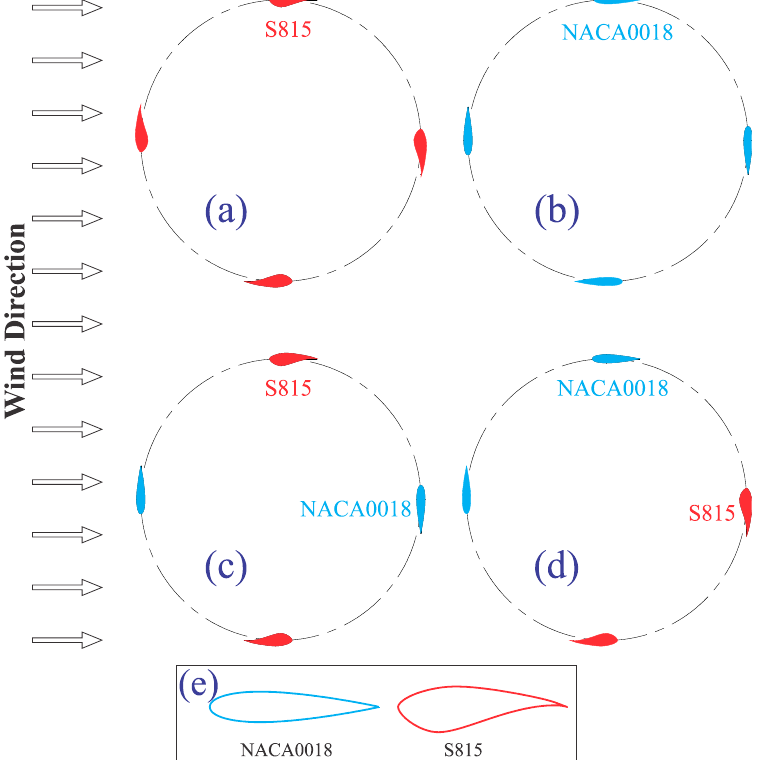
Figure 1. VAWTs at Δθ = 0°: ( a ) HT-S815; ( b ) HT-NACA0018; ( c ) NSA-1 and ( d ) NSA-2; and ( e ) 2D Figure 1. VAWTs at ∆ θ = 0 ◦ : ( a ) HT-S815; ( b ) HT-NACA0018; ( c ) NSA-1 and ( d ) NSA-2; and ( e ) 2D blade section. blade section.